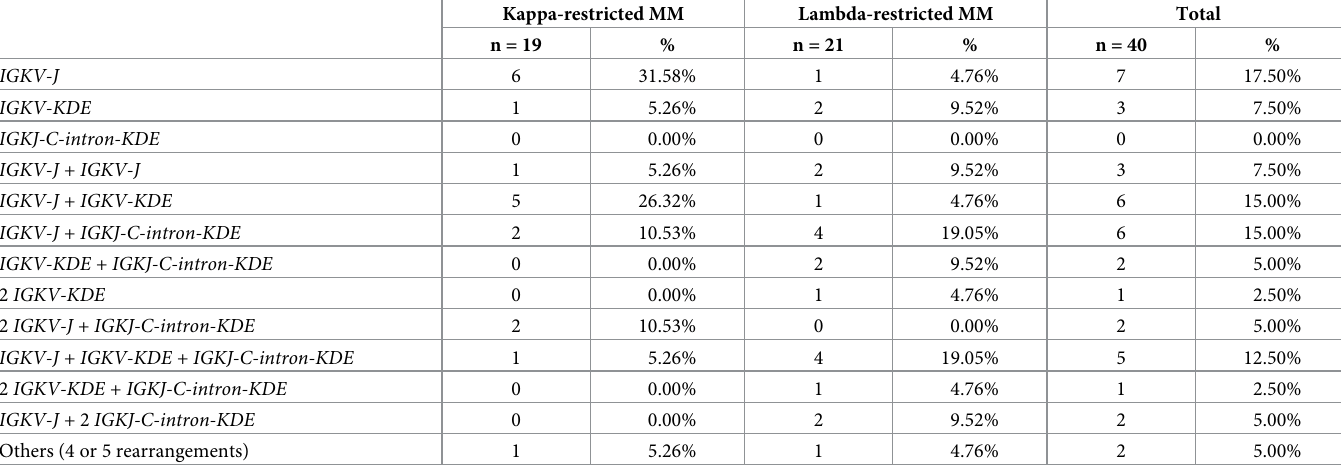
Table 5. Distribution of 85 IGK locus rearrangements from 40 samples with clonal igk rearrangement.